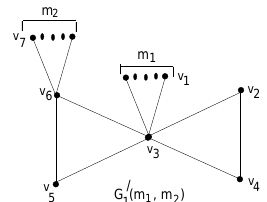
Figure 3: Bicycle graphs with two cycles G (cid:48) 1 ( m 1 , m 2 )